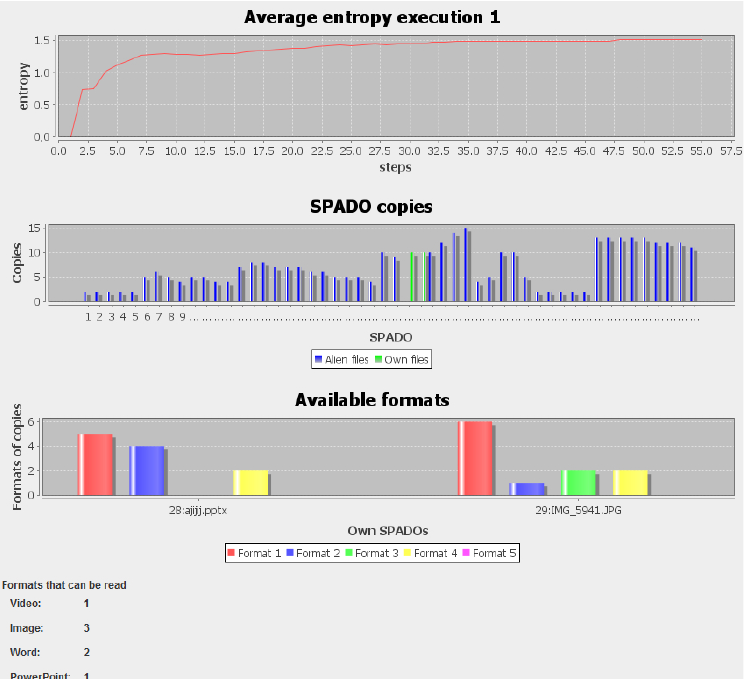
Figure 5. TiM graphical user interface for the system initialization and real-time execution